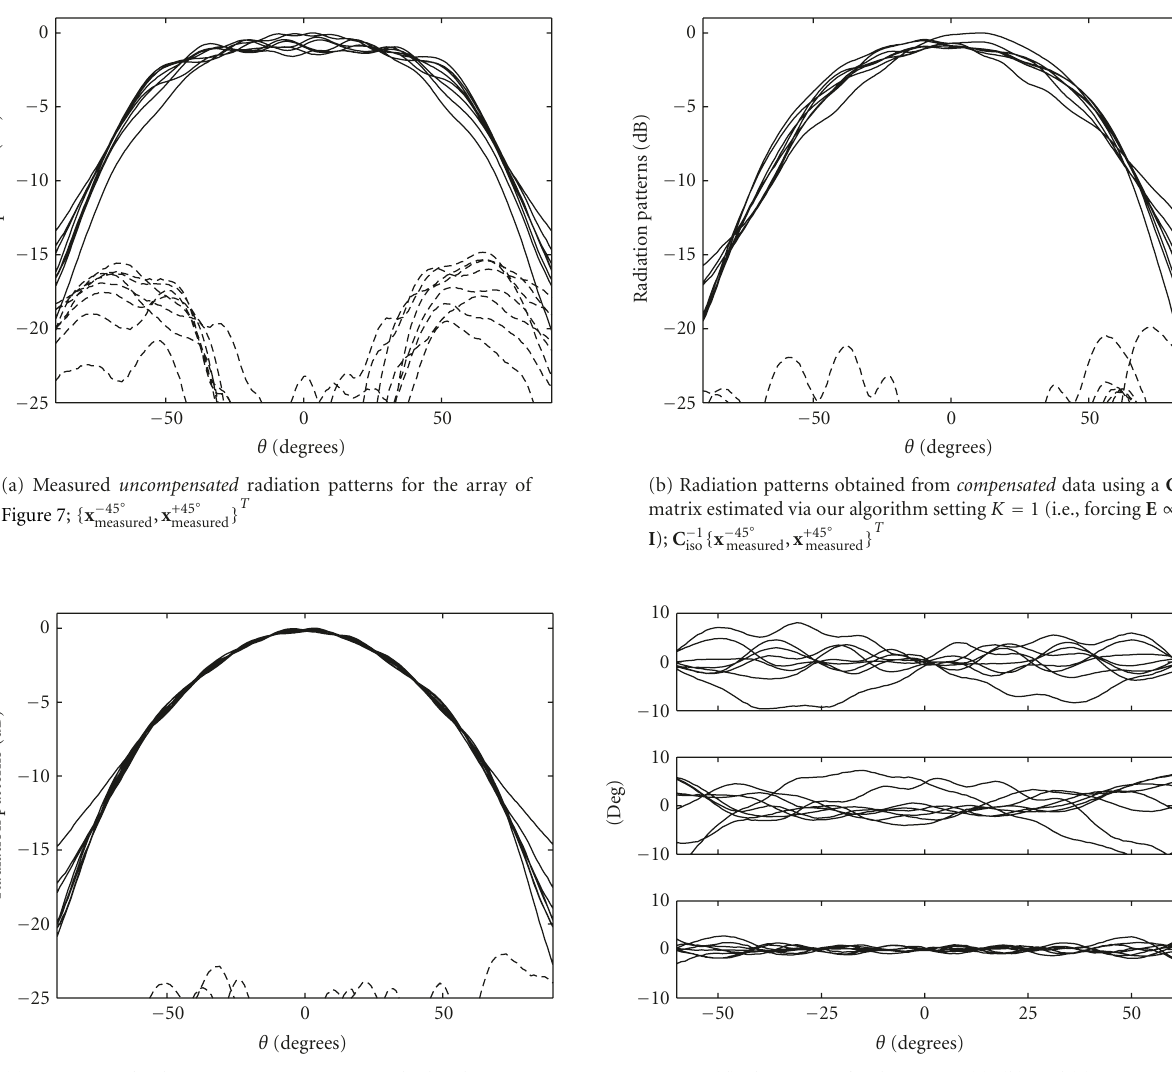
presented in the same graph and represents the impact of the noise. This is seen as an increase of the CRB in the region K >